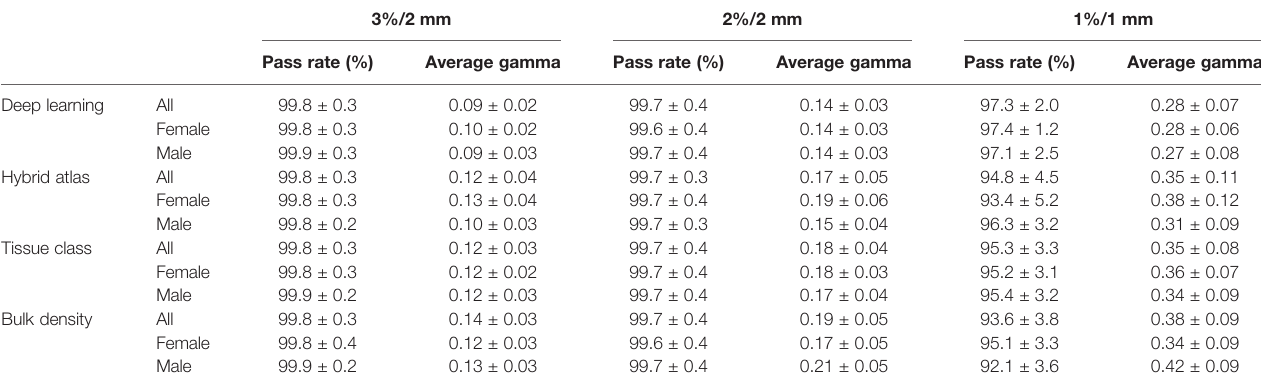
TABLE 4 | 3D gamma dose comparison for each sCT technique (mean ± 1